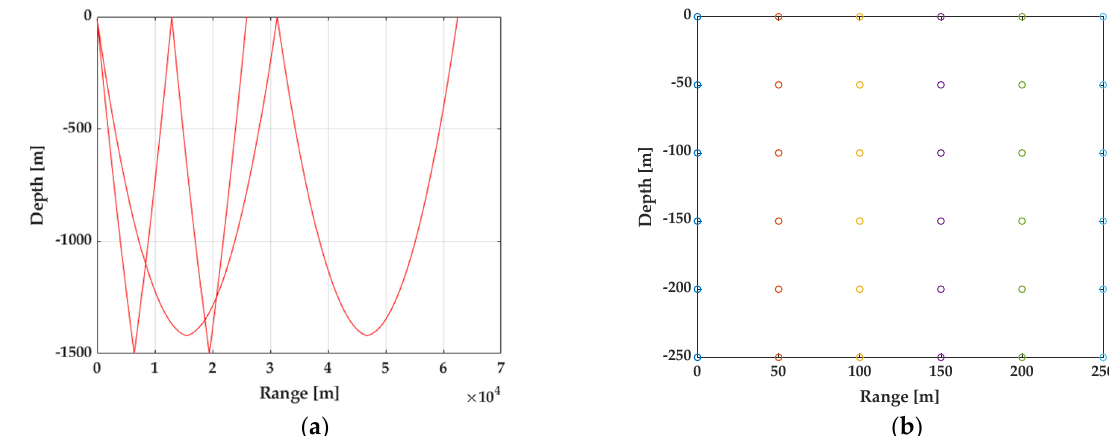
Figure 4. Simulation setup: ( a ) rays of propagation; ( b ) receiver matrix.